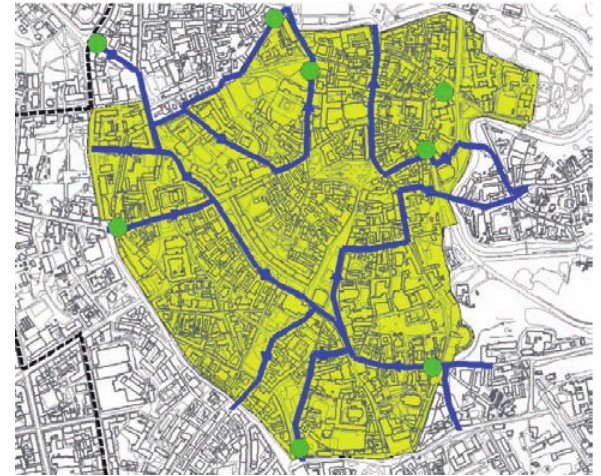
fig. 8. Scheme of loop entrance to the Old Town